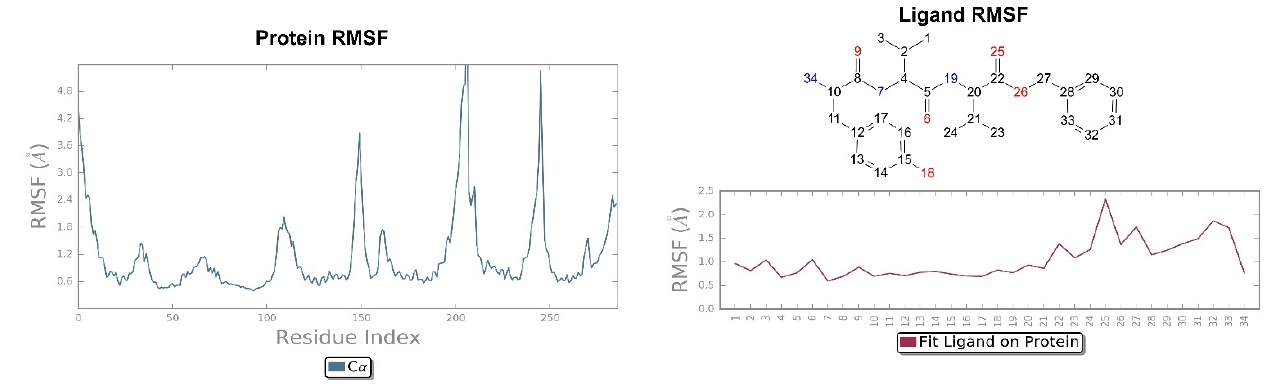
Figure 13. On the left: P-RMSF for KOR; on the right: L-RMSF of H-D-Tyr-D-Val-Val-OBz.